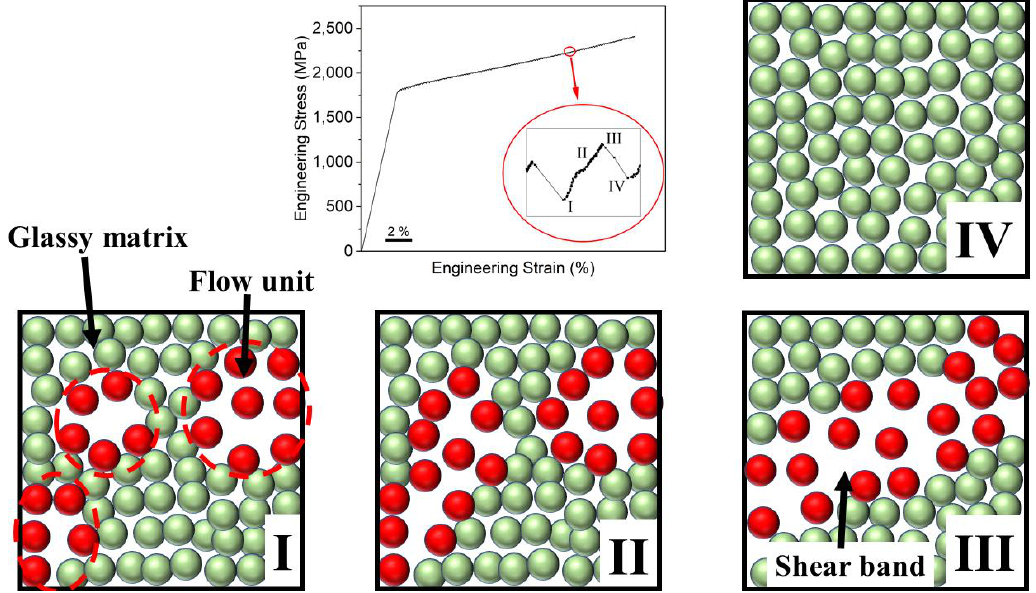
Figure 9. An illustration of the serration process that occurs due to the flow defect accumulation in a BMG during compression. Each numbered section corresponds to the evolution of the flow unit and glassy matrix during the serration event as follows: ( I ) activation of flow units in liquid-like regions under an applied stress, ( II ) growth and coalescence of the liquid-like cites with adjacent cites with an increase in stress, ( III ) initiation of a shear band when a critical stress is reached, and ( IV ) a drop in the stress that is accompanied by shear-band arrest and subsequent restoration of the glassy matrix in the shear plane (adapted from Reference [197]). Table 1. Some of the underlying mechanisms of the serrated flow in crystalline and amorphous alloys. Material System Serration Mechanism